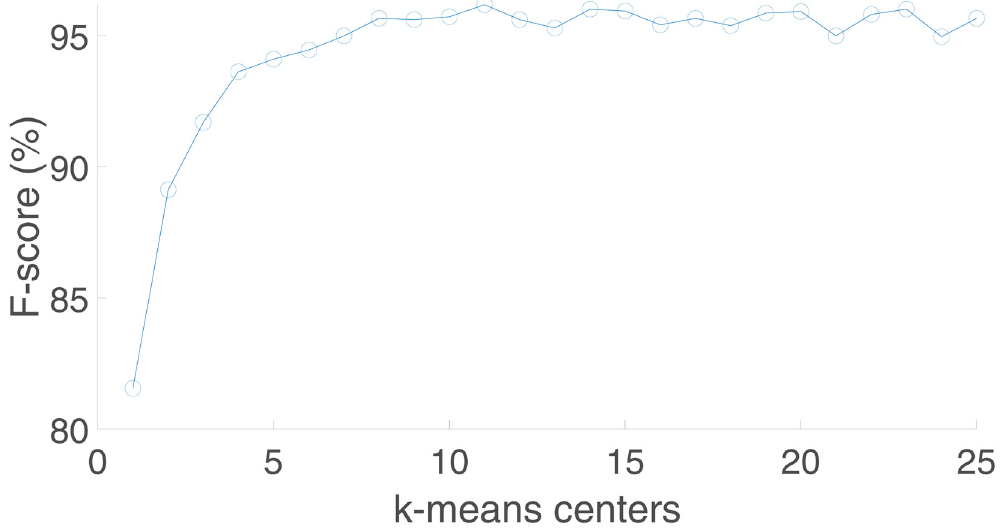
Fig 10. Evolution of F-score with respect to the number of k-means clusters for the hand pose recognition.